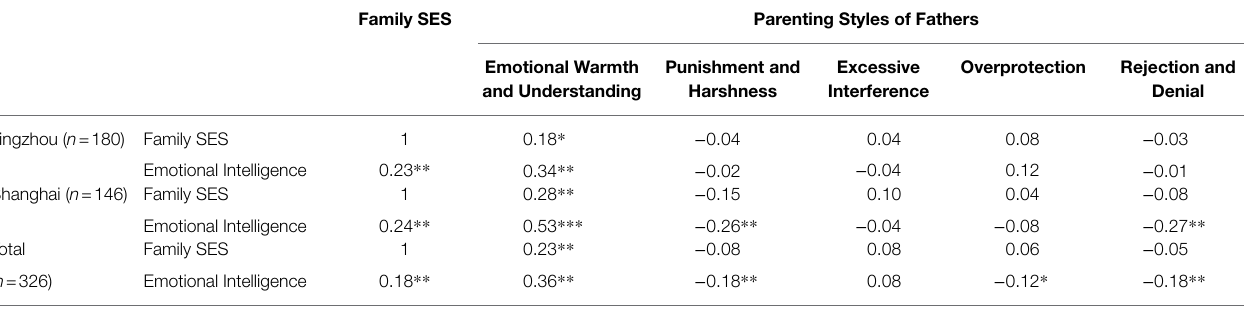
TABLE 4 | The correlation between primary school students’ family socioeconomic status, father’s parenting style, and emotional intelligence.